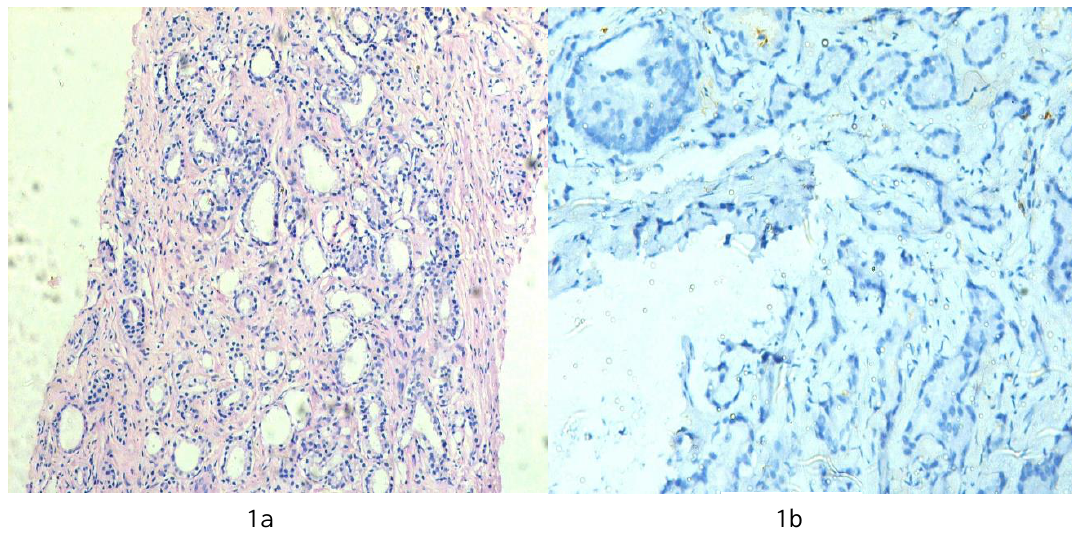
Figure 1. a: Photomicrograph depicting adenocarcinoma Gleason Score (3+3=6) (H&E, 100X) b: On IHC, CD10 negative